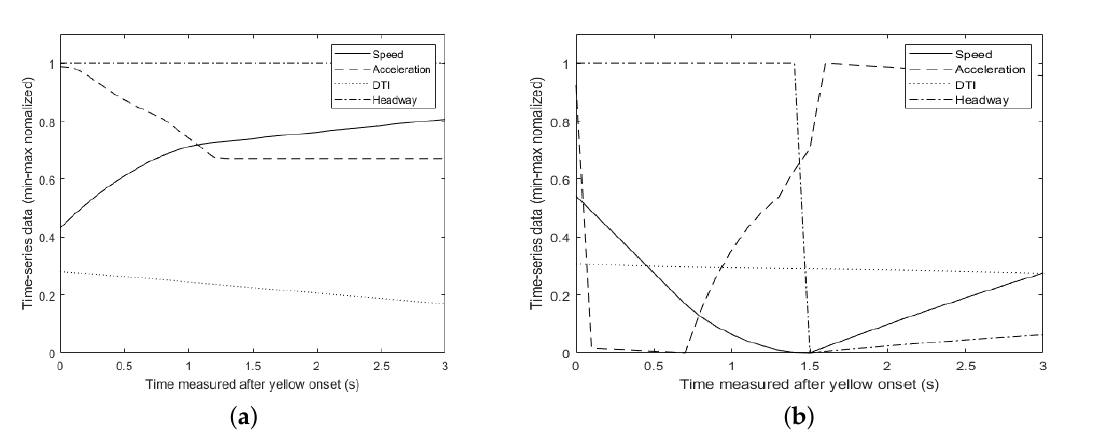
Figure 3. Comparison of driving profiles from two different Red Light Runner (RLR) clusters. ( a ) Speed maintenance pattern; ( b ) Acceleration after deceleration by the preceding vehicle